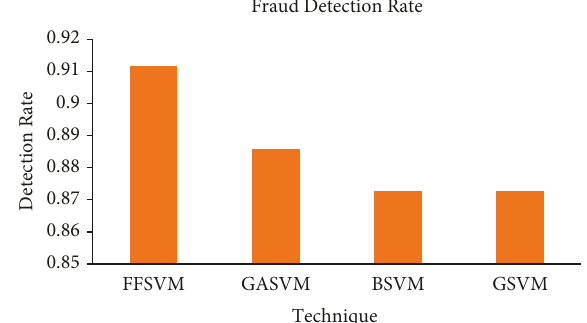
Figure 4: Comparison between the proposed algorithm and three other search algorithms (BSVM, GSVM, and GASVM) in terms of the fraud detection rate.